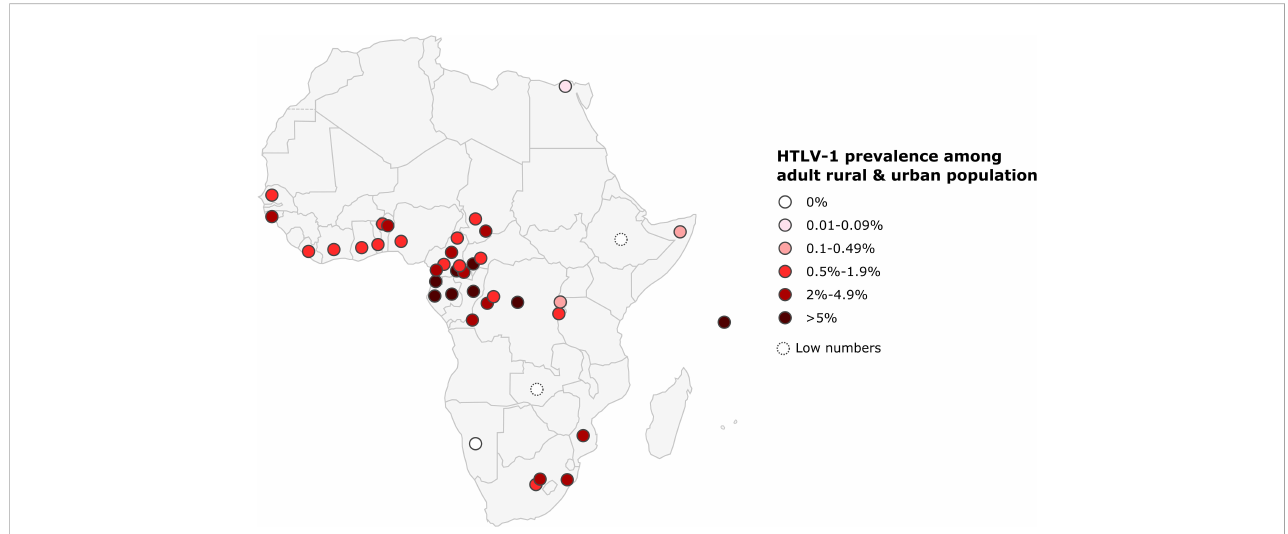
FIGURE 6 Map of Africa showing location and results of HTLV-1 prevalence studies among rural and urban adult population. The range of HTLV-1 prevalence is indicated by color of red gradient. In case of great geographical or inter-studies variations in prevalence within a country, each result was represented separately at the site of the study location (when available). Studies with low numbers (below 150) are indicated with a dashed